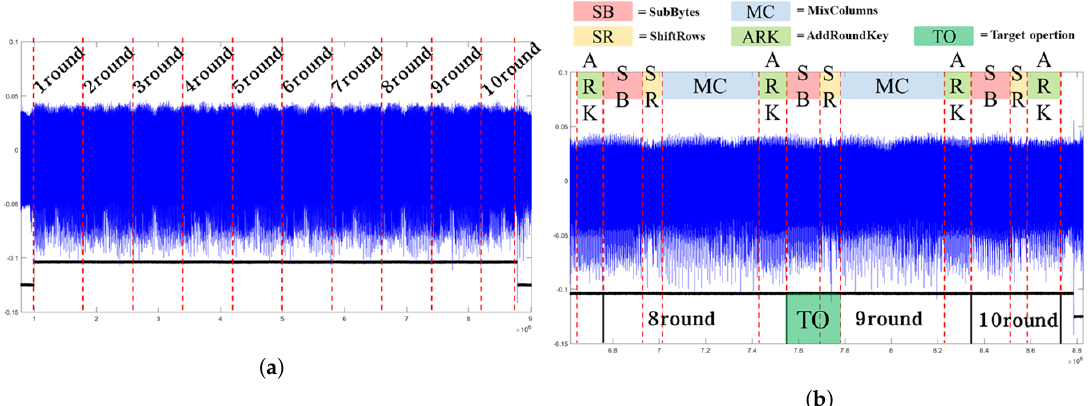
Figure 7. ( a ) Electromagnetic trace of AES; ( b ) Electromagnetic trace of 8th, 9th, and 10th AES.